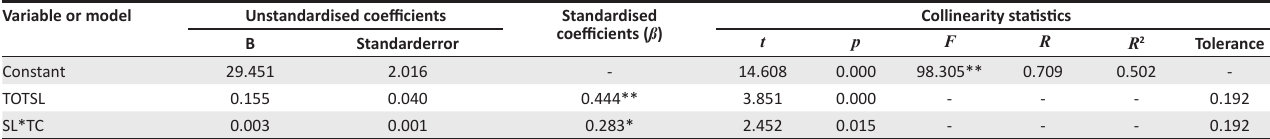
TABLE 4: Standard regression analysis: Testing moderating effect. Variable or